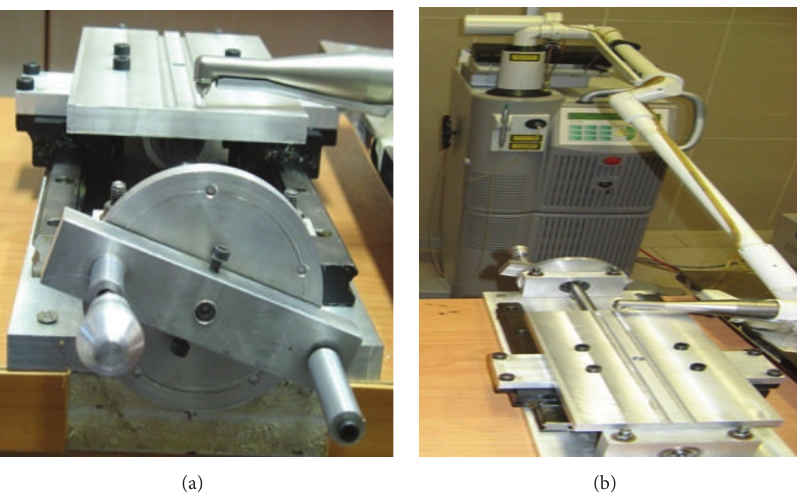
Figure 1: The table was designed to keep the laser sample distance, laser speed, and angle of laser ray constant. The brackets were placed on a slot propped on the table. The laser handpiece-bracket distance was 1mm for all the samples.